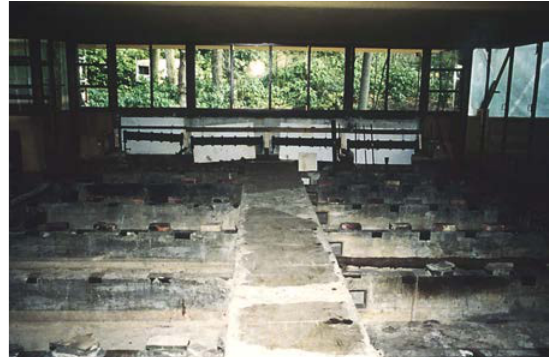
Figure 3. The gutted living room looking south at the windows (Wank Adams Slavin Associates, 2004)